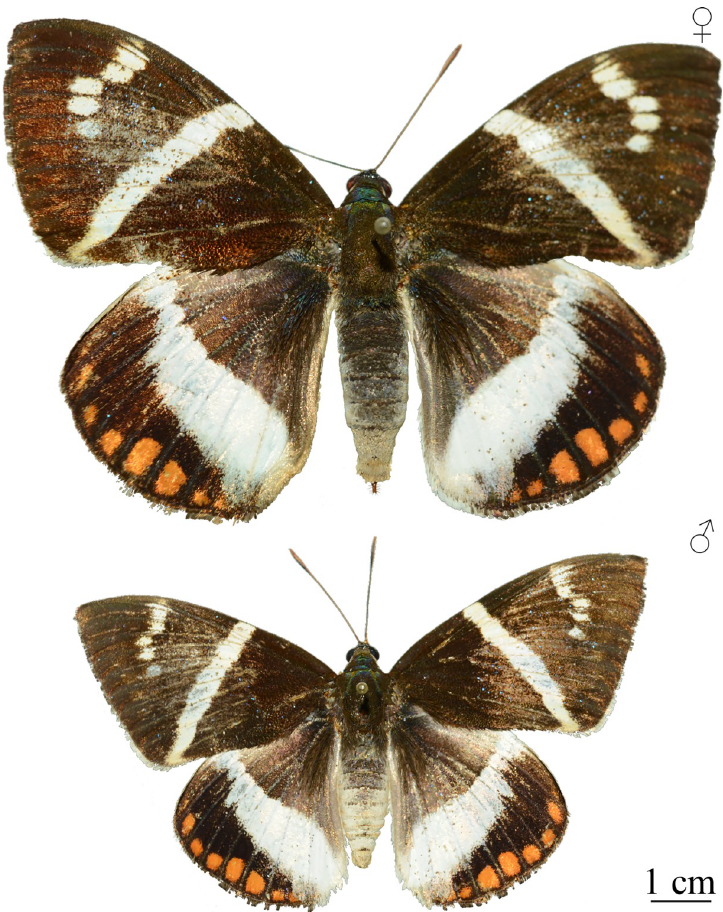
Fig 1. The giant sugarcane borer ( Telchin licus ). Female and male T . licus in dorsal view. The apparent difference in their sizes in this illustration is a particularity of these two individuals and does not reflect a trend for the species.